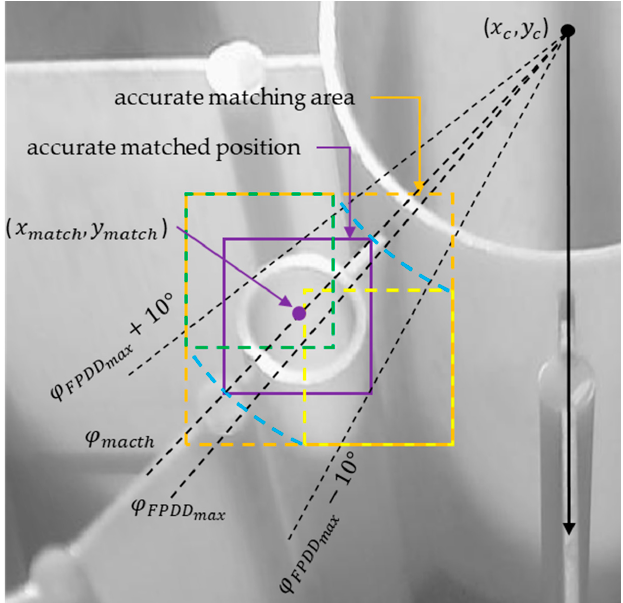
Figure 9. Accurate matching in pre ‐ located area.